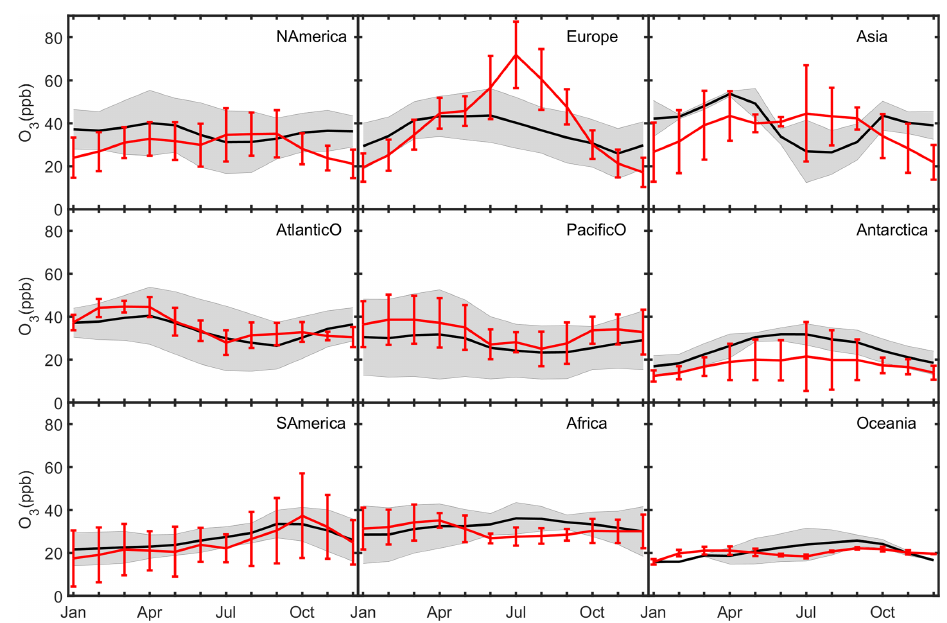
Figure 6. Mean seasonal variation of O 3 (in ppb) over the NAmerica, Europe, Asia, AtlanticO, PacificO, Antarctica, SAmerica, Africa, and Oceania sites. Black and red lines represent the average of observations and simulations respectively. Grey shaded areas and red vertical bars show ± 1 standard deviation for observations and for model results